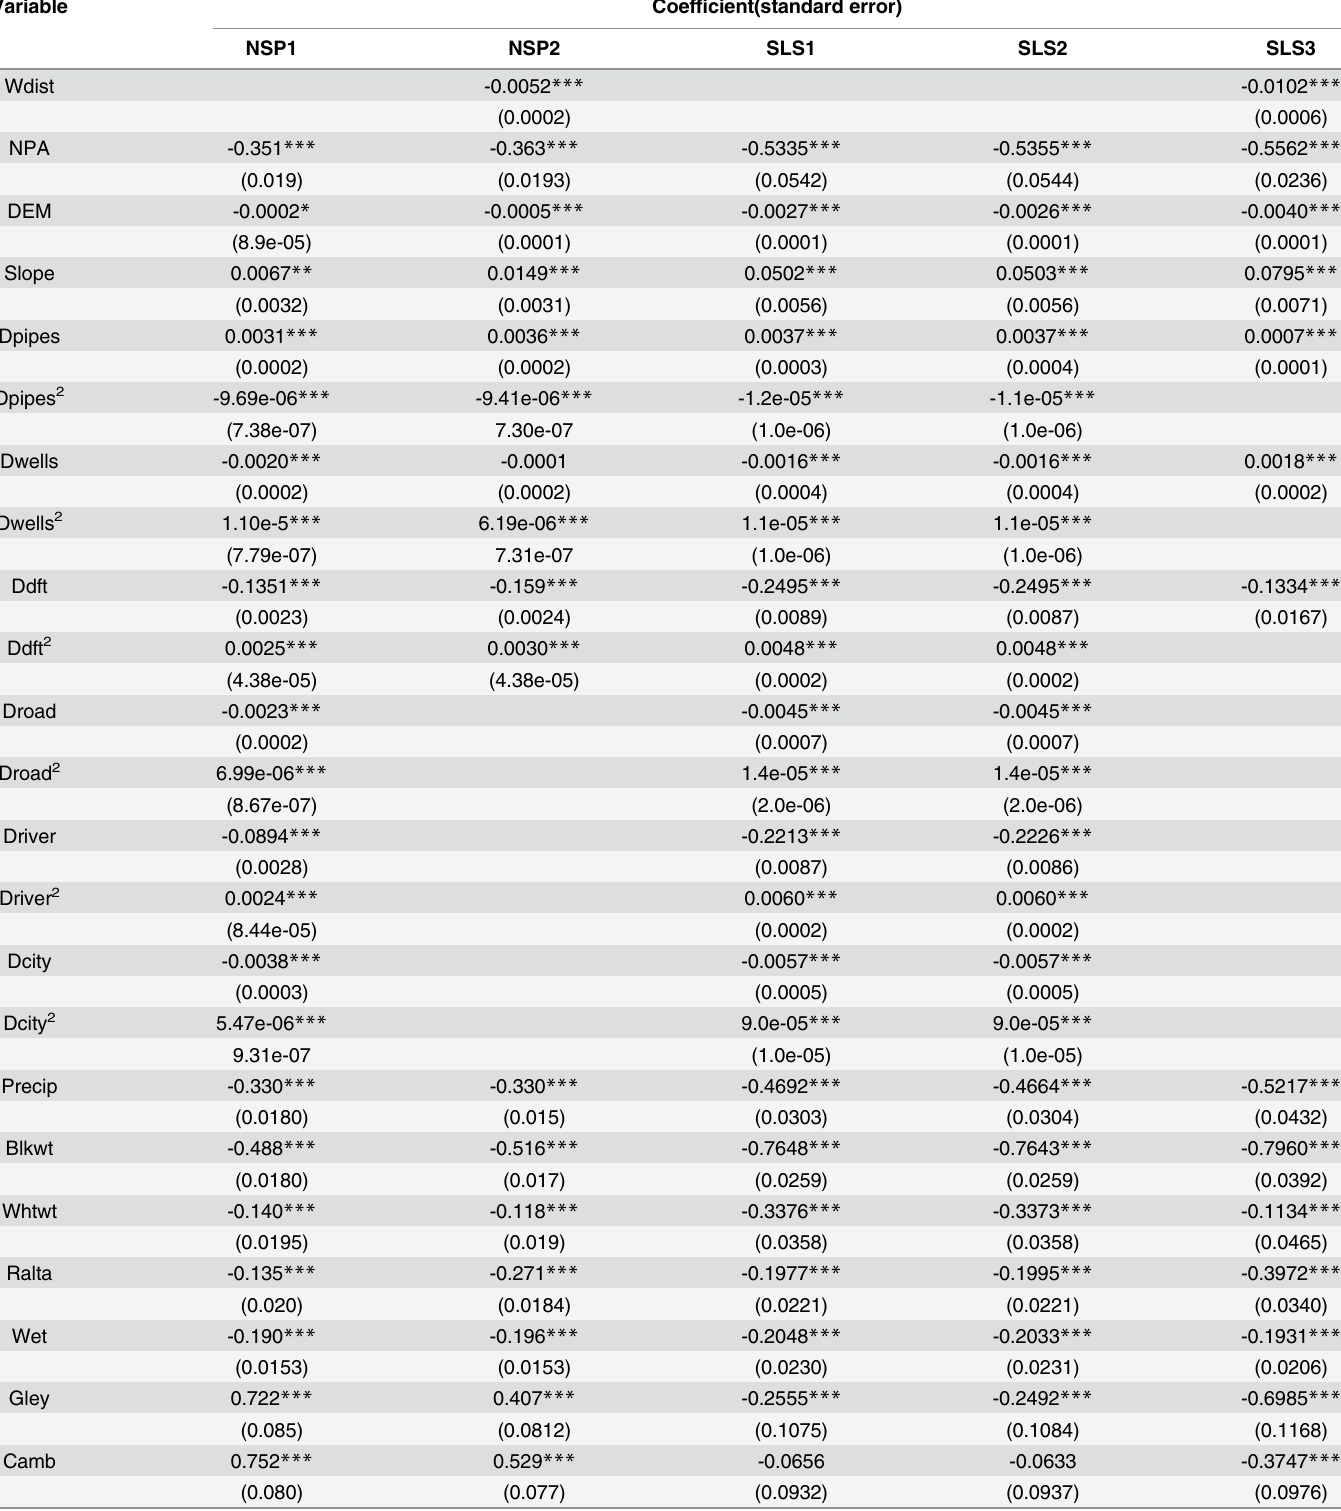
Table 3. Regression results for non-spatial probit (NSP) and SLS spatial